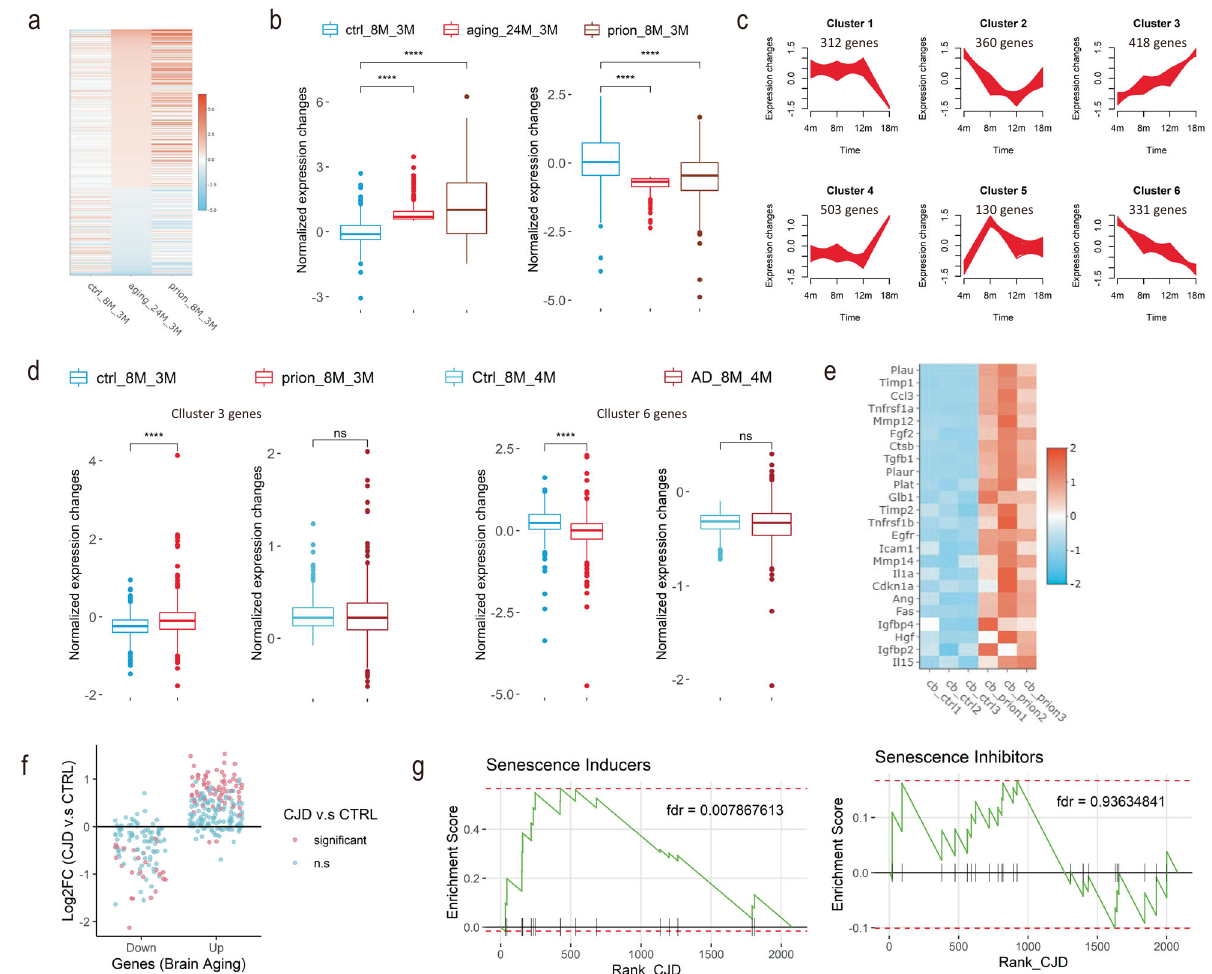
Fig. 5 Prions accelerate biological brain aging in vivo. a Heatmap showing the normalized fold changes of in vivo brain-aging-signature genes across conditions. ctrl_8M_3M: 8-month vs. 3-month hippocampus in control (NBH-exposed) mice; prion_8M_3M: 8-month vs. 3-month hippocampus in prion- infected mice; aging_24M_3M: 24-month vs. 3-month hippocampus in normal mice. b Quanti fi cations of normalized expression changes of aging- signature genes shown in a . Left panel: upregulated brain-aging-signature genes shown in a . Right panel: downregulated brain-aging-signature genes shown a . **** p -value < 0.0001. c In vivo brain-aging-associated genes clustered by fuzzy c-means. Only those genes with cluster membership values